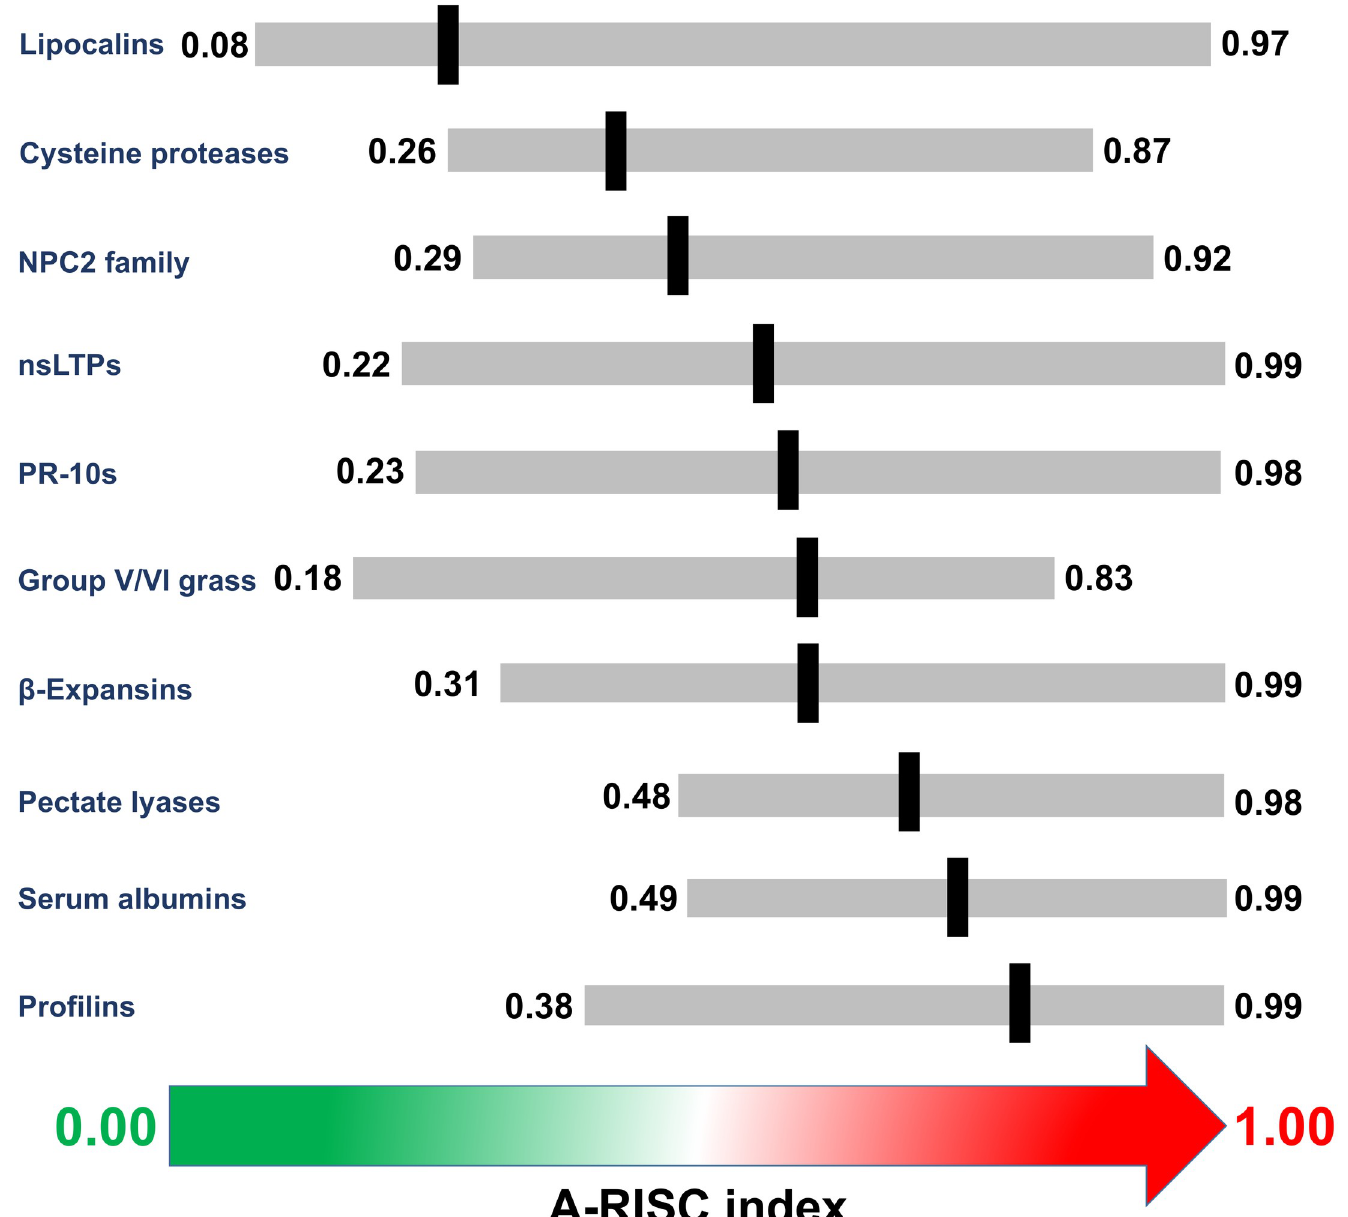
Fig 29. A-RISC indexes for various allergen families. Gray bars correspond to observed A-RISC ranges. The black horizontal lines indicate an average A-RISC index for a family.